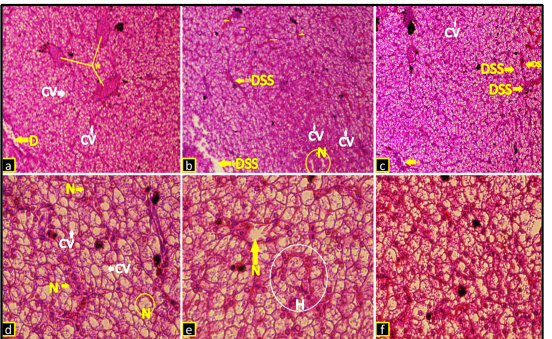
Figure 2. The tissue damage in grass carp ( Ctenopharyngodon Idella ) fingerlings exposed to DZN: ( a ) Liver exposed to 1 mg L − 1 after 96 h (H&E, 10×), displaying cytoplasmic vacuolation (CV), vascular dilation (D), and the aggregation of erythrocytes within hepatic blood vessels (*). ( b ) Exposure to 1.5 mg.L − 1 after 96 h (H&E, 10×), revealing cytoplasmic vacuolation (CV), necrosis (N), congestion of erythrocytes (yellow line), and dilation of sinusoids (DSS). ( c ) Exposure to 1.5 mg.L − 1 after 96 h (H&E, 10×), indicating cytoplasmic vacuolation (CV), dilation of sinusoids (DSS), and the aggrega- tion of erythrocytes within hepatic blood vessels (*). ( d ) Exposure to 2 mg L − 1 after 96 h (H&E, 40×), exhibiting cytoplasmic vacuolation (CV) and necrosis (N). ( e ) Exposure to 2.5 mg.L − 1 after 96 h (H&E, 40×), illustrating necrosis (N) and hyperaemia (H). ( f ) Exposure to 3 mg.L − 1 after 96 h (H&E, 40×), depicting the extensive necrosis of the liver.